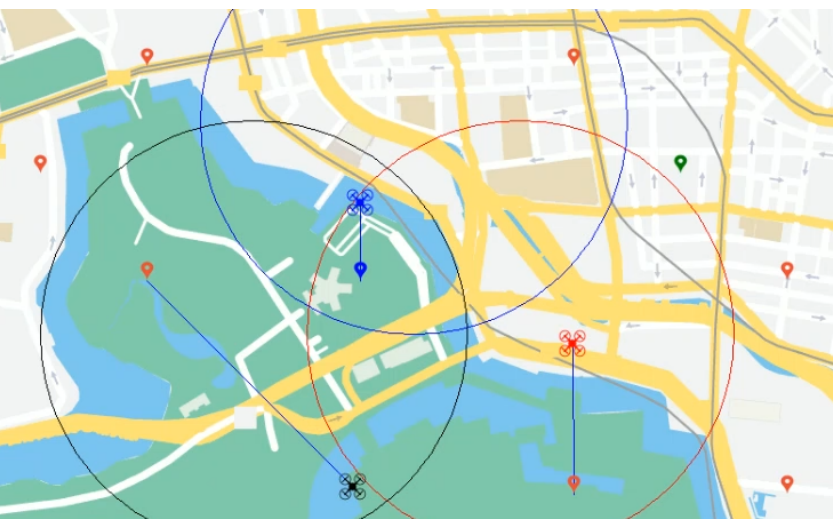
Figure 2. Drone team allocation problem